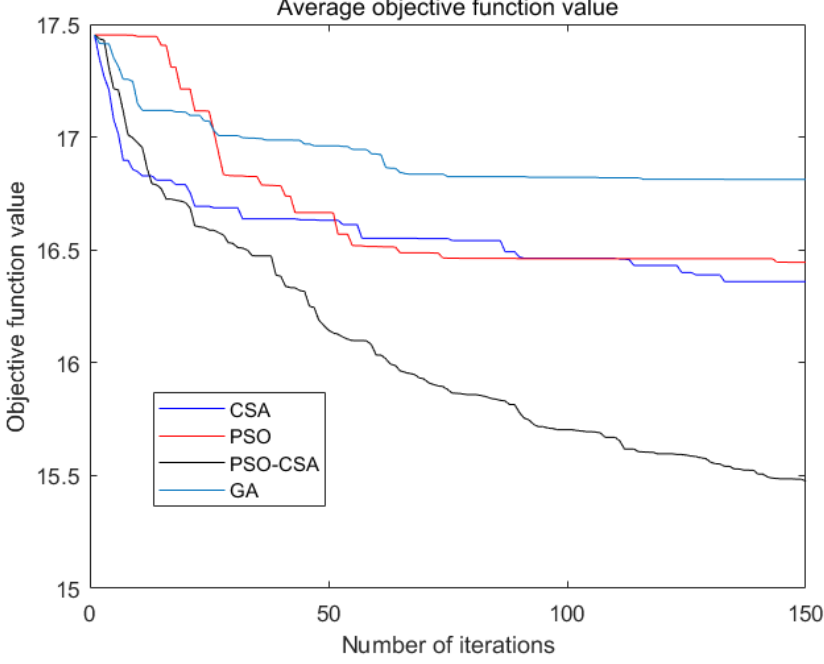
Figure 5. Average convergence curves for the four algorithms.